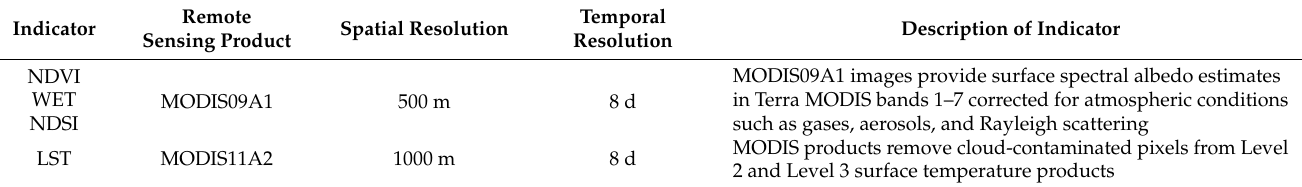
Table 1. The data source and index descriptions of four ecological components.